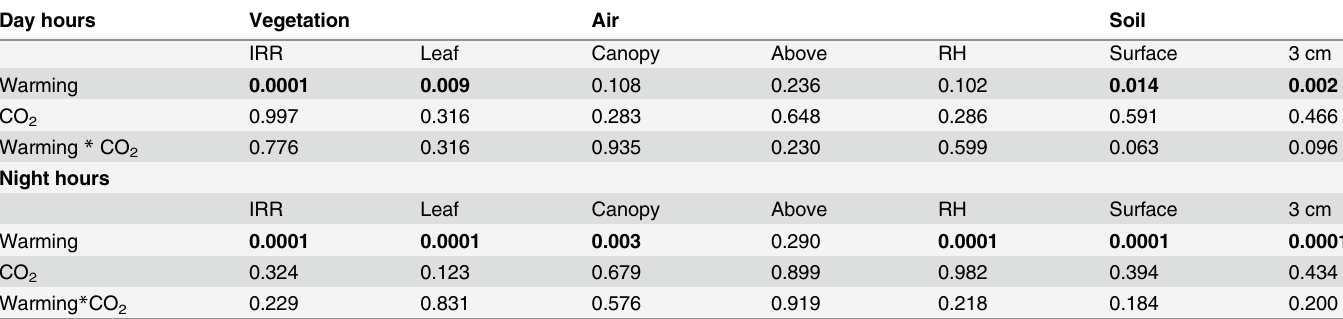
Table 1. Probabilities of warming and CO 2 effects on microclimate temperatures and RH at the PHACE experiment.